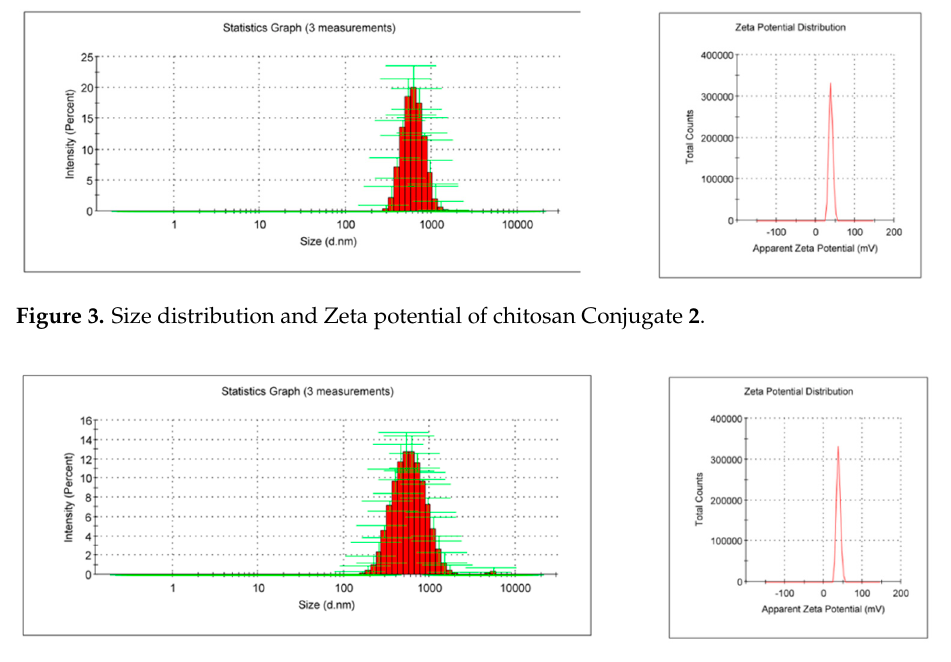
Figure 4. Size distribution and Zeta potential of chitosan Conjugate 3 .